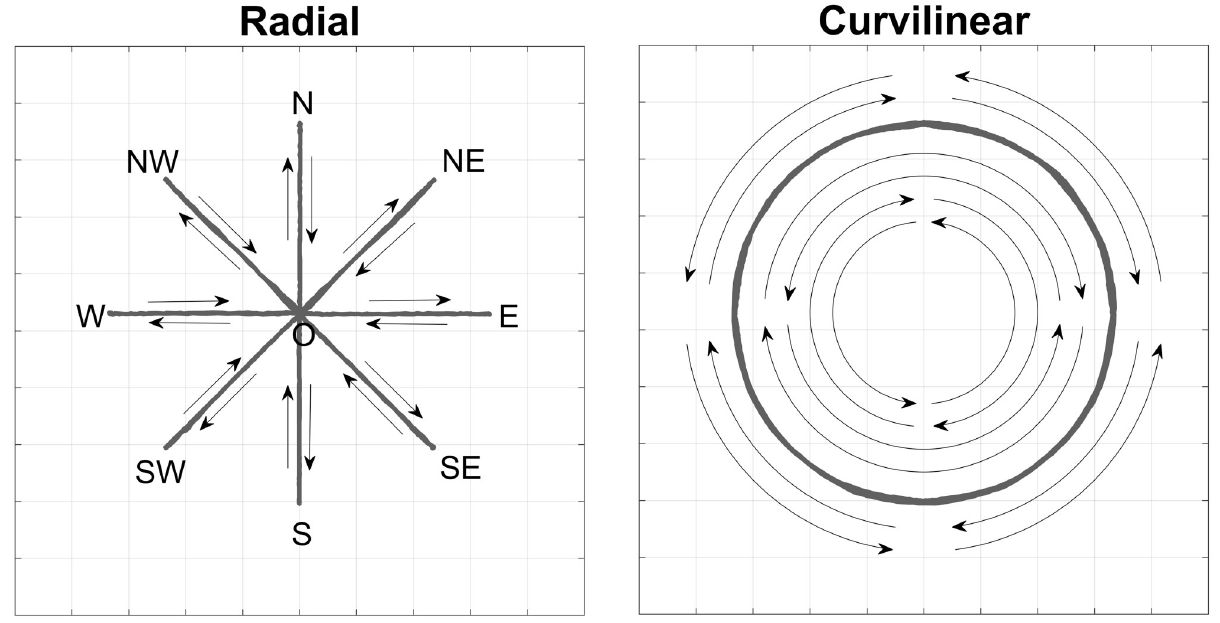
Fig 3. A schematic representation of exercises trajectories: Radial (left) and curvilinear (right).